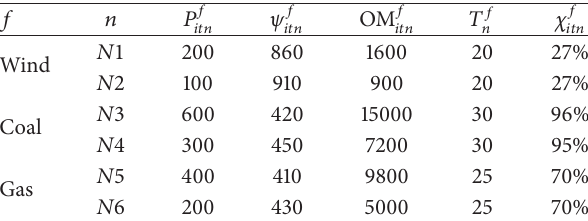
Table 5: Coefficients of original units.